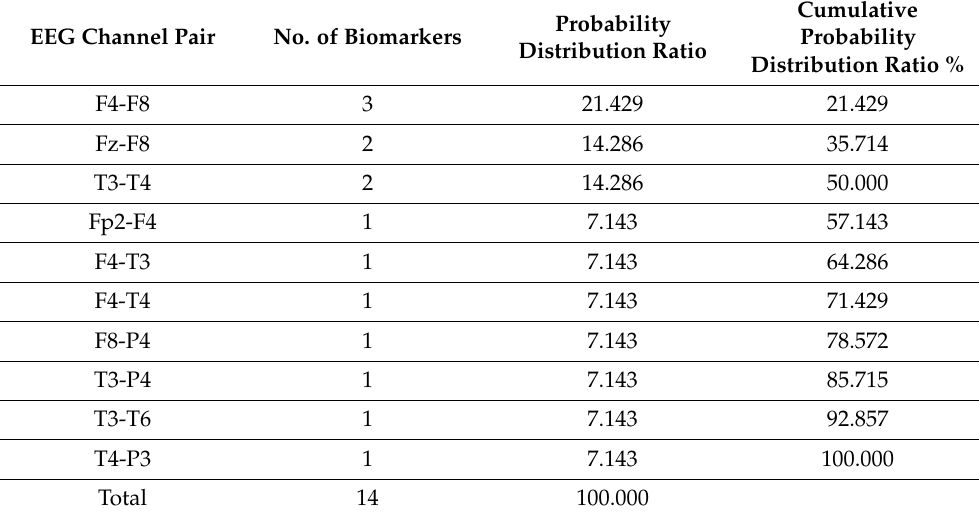
Table 5. Probability distribution ratio to EEG coherence for all 25 EEG biomarkers and all 19 EEG